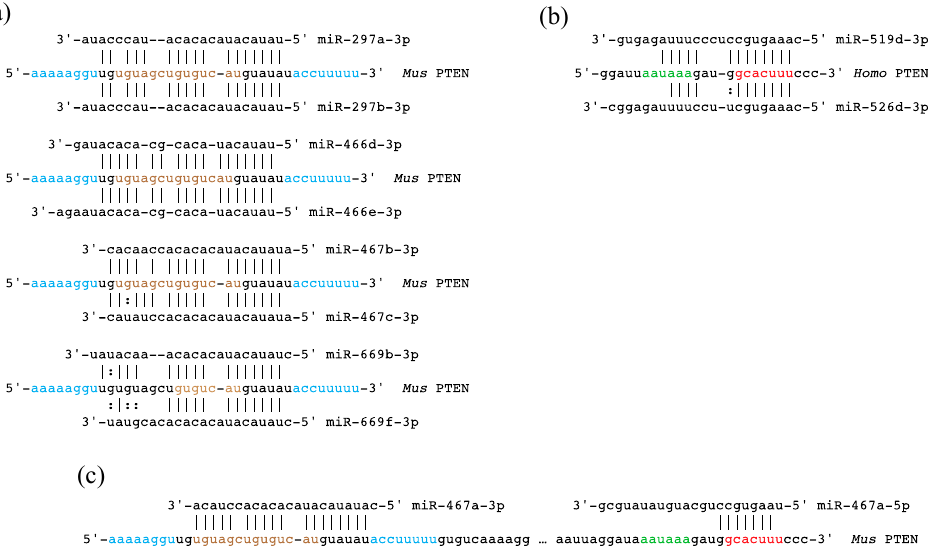
Figure 4. Predicted targeting of PTEN 3 ′ UTR by imprinted miRNAs. ( a ) A sample of the many miRNAs from the C2MC cluster of imprinted miRNAs that exhibit extensive complementarity to the “upstream hairpin”. ( b ) Predicted binding of miR-519d-3p and miR-526d-3p from the C19MC cluster of miRNAs to the ancient miR-17-5p target site. ( c ) pre-miR-467a is present in 10 copies per haploid genome and is processed into miR-467a-5p, which is predicted to target the miR-17-5p target site of the “roquin hairpin”, and miR-467a-3p, which is predicted to target the “upstream hairpin”. Color coding of sequence elements is the same as in Figure 3.